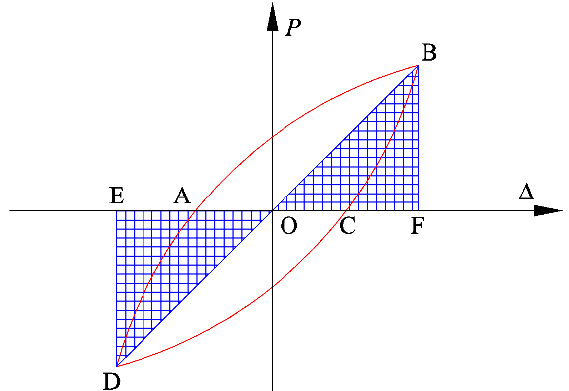
Figure 12. Typical hysteretic loop.